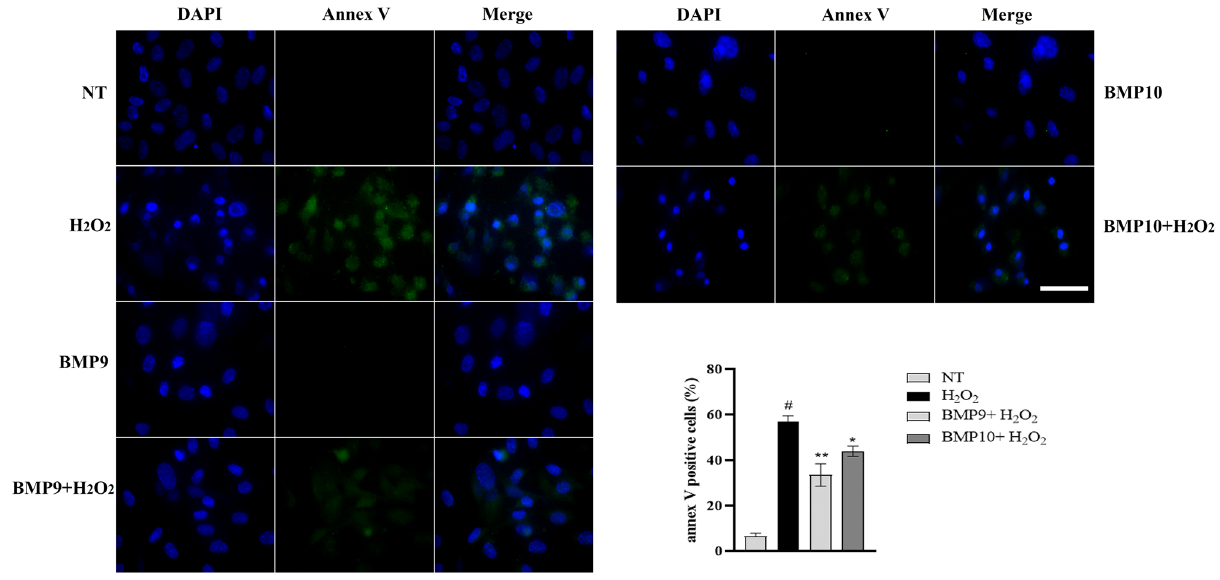
Figure 6. BMP9 and BMP10 mitigate apoptosis induced by H 2 O 2 . Annexin (Annex) V-FITC staining analysis (green) in HUVECs following a 6h treatment with 500 µM H 2 O 2 in the absence or presence of a 24 h pre-incubation with BMP9 and BMP10 (10 ng/mL). Nuclei are counterstained by using DAPI, as detailed in Materials and Methods. Scale bar=50 μm. Histogram shows densitometric analysis of Annexin V-positive